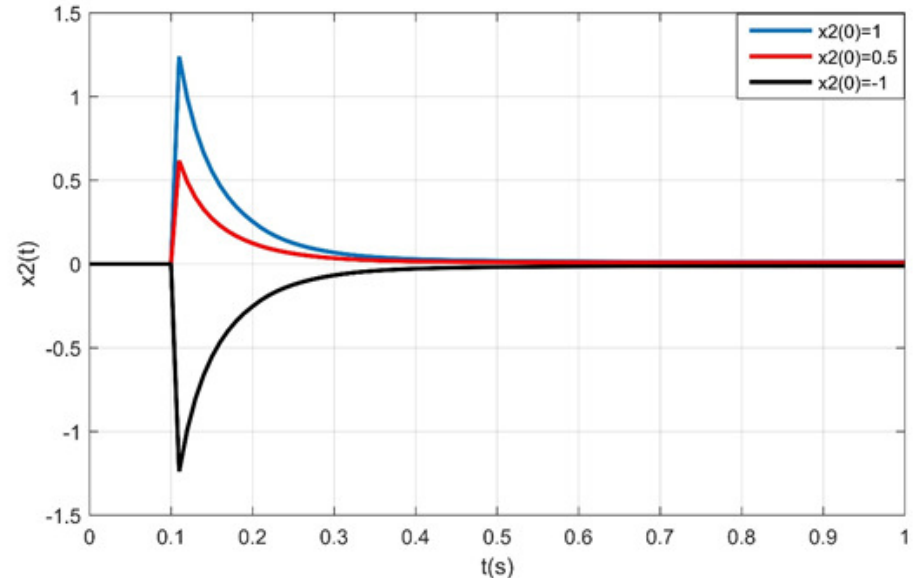
Figure 8. The boundedness of solution x 2 ( t ) of the system of IFrRDEs in Equation (13) for q = 0.5, τ = 1 , ρ = 1 and different initial values when t ≥ 1 5 10